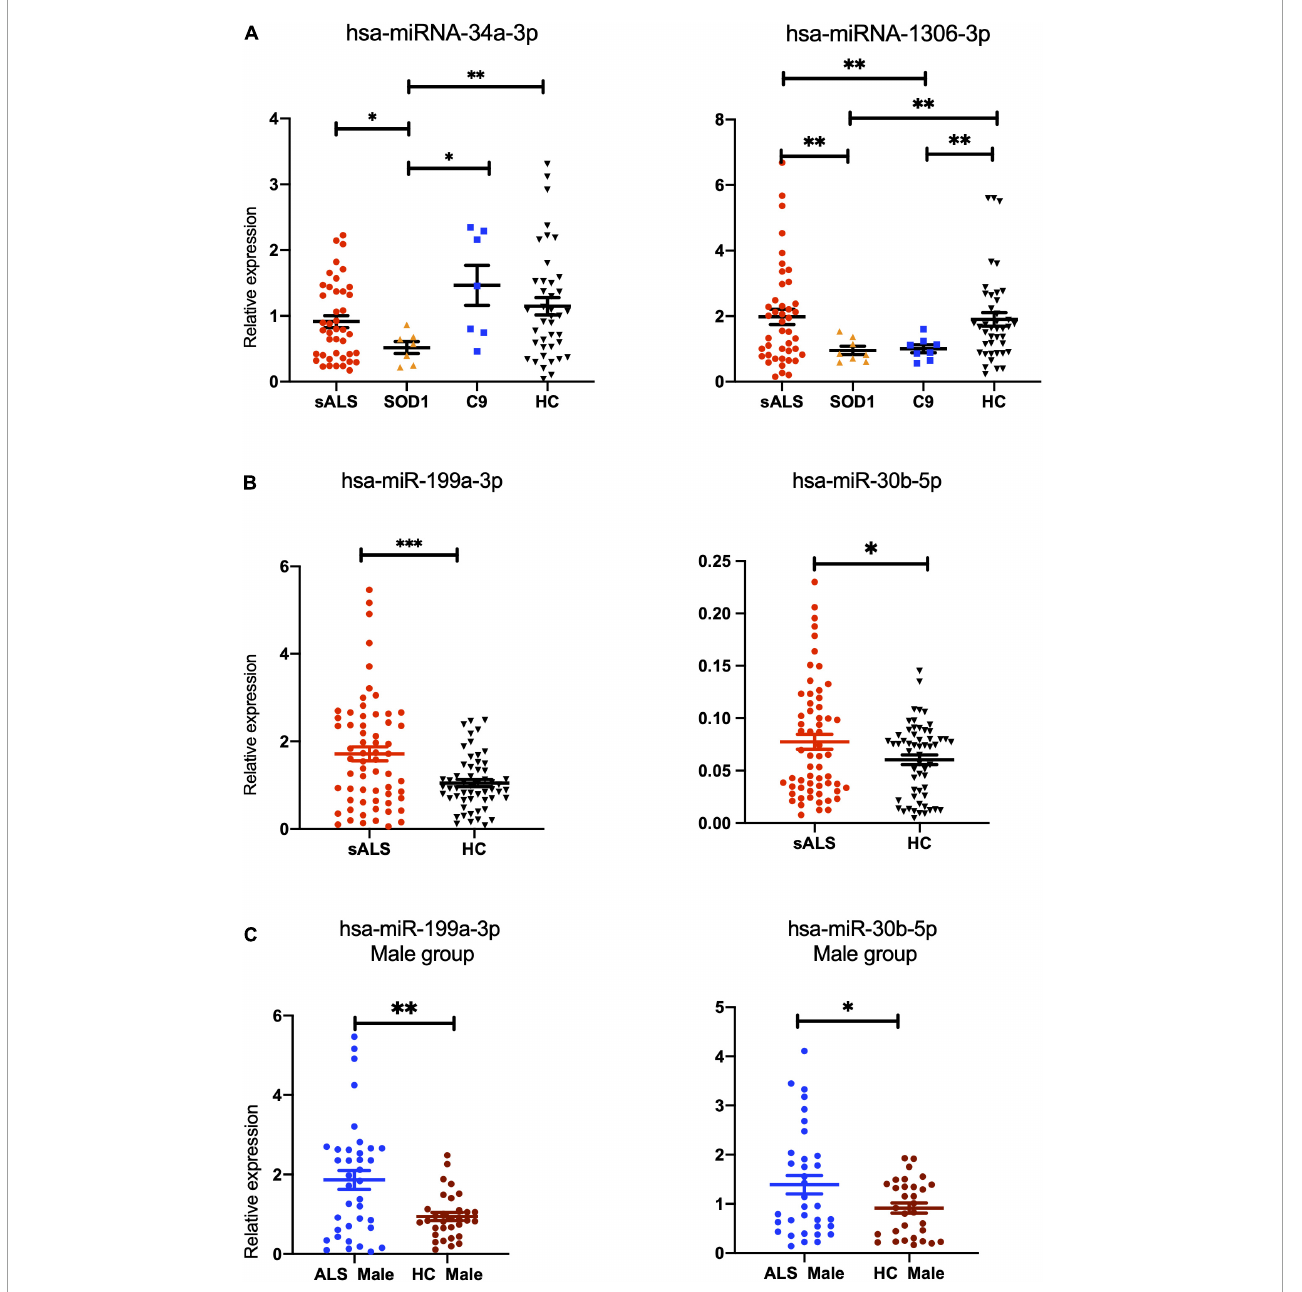
FIGURE3 The differentially expressed miRNAs found in patients with gene-mutant and sporadic ALS compared with healthy controls validated by RT-qPCR. (A) hsa-miR-34a-3p was found to be specifically downregulated in patients with SOD1 -ALS compared to patients with C9orf72 -ALS ( p = 0.0175), sporadic amyotrophic lateral sclerosis (SALS) ( p = 0.032), and HCs ( p = 0.0022), while no statistical significance was found between SALS and HCs ( p = 0.151). Interestingly, hsa-miR-1306-3p showed significant downregulation in ALS patients with SOD1 and C9orf72 gene mutations, compared to SALS and HCs (SALS vs. SOD1 -ALS: p = 0.0021, SALS vs. C9orf72 -ALS: p = 0.0032, SOD1 -ALS vs. HCs: p = 0.002, C9orf72 -ALS vs. HCs: p = 0.0032) and no statistical significance was found between SALS and HCs ( p = 0.807). (B) Compared to HC, hsa-miR-199a-3p ( p = 0.0003) and hsa-miR-30b-5p ( p = 0.0474) were found to be upregulated in patients with SALS ( p = 0.0474). (C) In the subgroup analysis on gender, compared to male HCs, hsa-miR-199a-3p ( p = 0.0014) and hsa-miR-30b-5p ( p = 0.0309) were confirmed to be upregulated significantly in the male SALS group. HCs, health controls. ∗∗∗ p < 0.001, ∗∗ p < 0.01, ∗ p < 0.05.